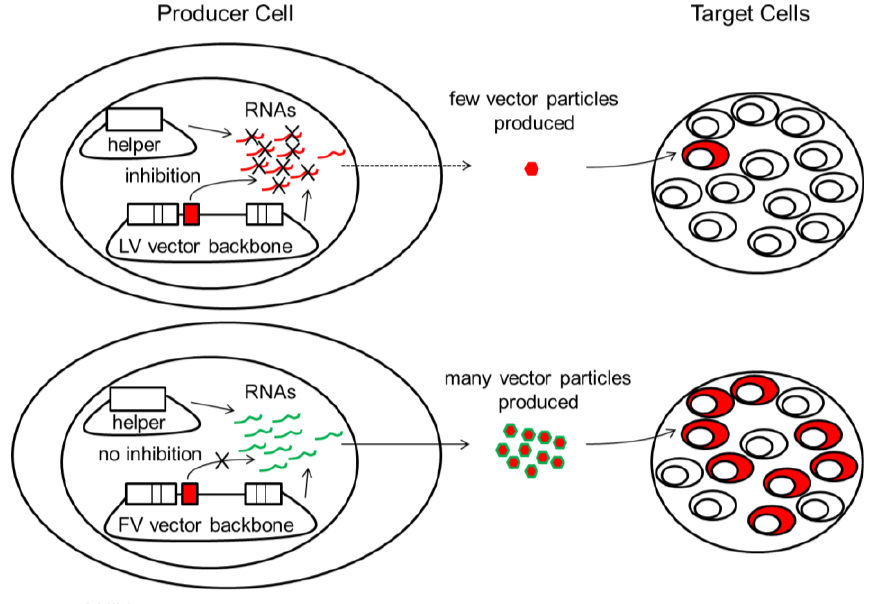
Figure 1. Inhibition of LV vector production by anti-HIV transgenes can lead to low titers and poor transduction efficiency in target cells. HIV-based LV vectors and HIV share identical nucleotide sequences and proteins. During LV vector production, LV vector backbones and LV helper plasmids are cotransfected into producer cells to produce LV vector virions for infecting target cells. LV vector plasmids and/or LV helper plasmids and their respective RNAs can be targeted by some anti-HIV transgenes such as short hairpin (sh)RNAs (red box). This can result in a reduction in the number of vector particles produced, leading to inefficient transduction of target cells by low titer LV vector. FV vector plasmids, FV helper plasmids, and their respective RNAs are not affected because FV vectors do not share significant sequence identity with HIV. HIV/LV vector components and anti-HIV transgenes are indicated in red. FV vector components are indicated in green. LV, lentivirus; FV, foamy